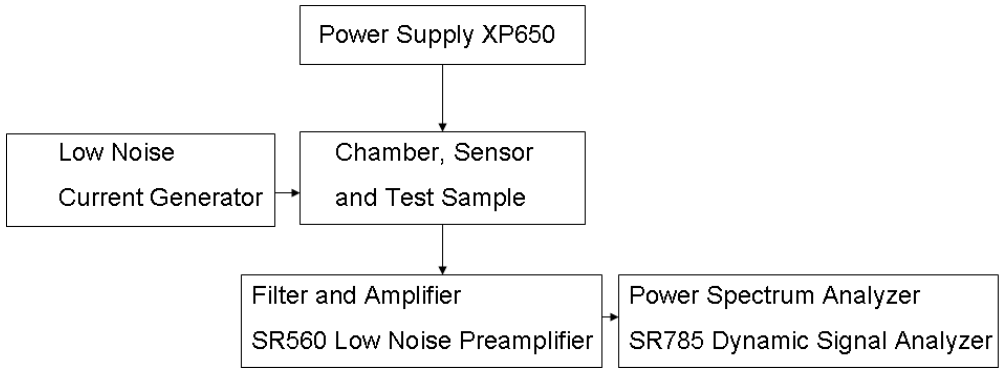
Figure 4. Outline of the experimental